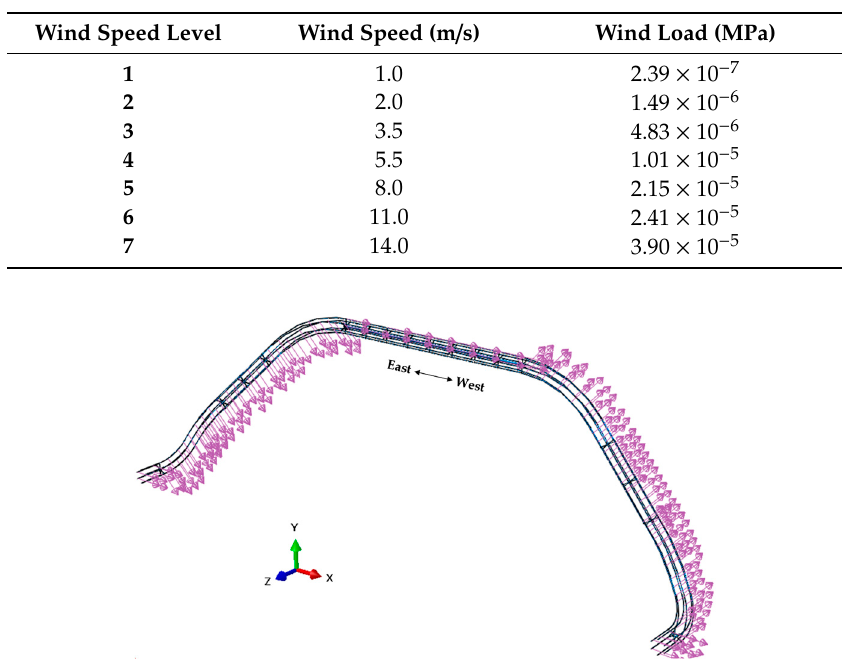
Table 2. Magnitude of wind load applied to the surface of the conductor corresponding to different wind speeds.